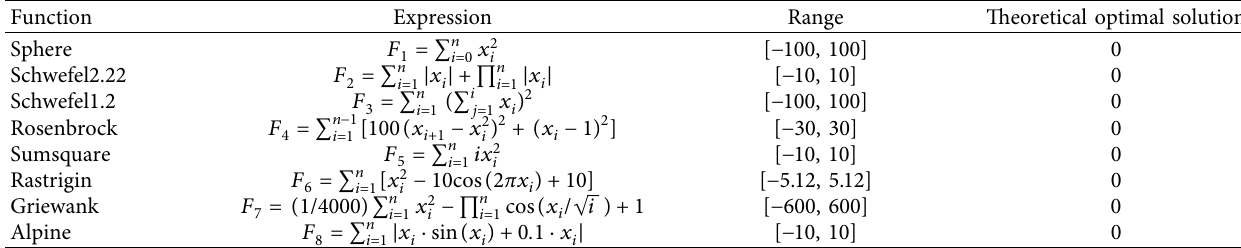
Table 1: [33] Main characteristics of 8 benchmark functions.